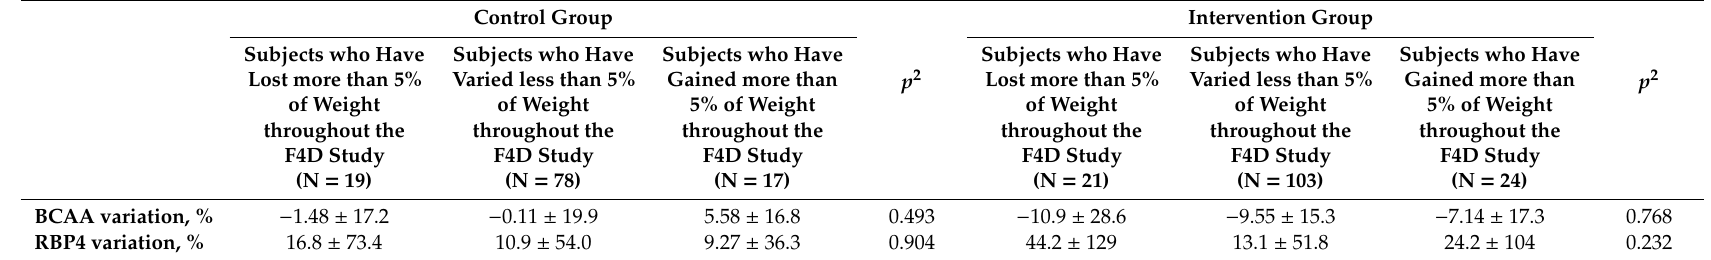
Intervention Group